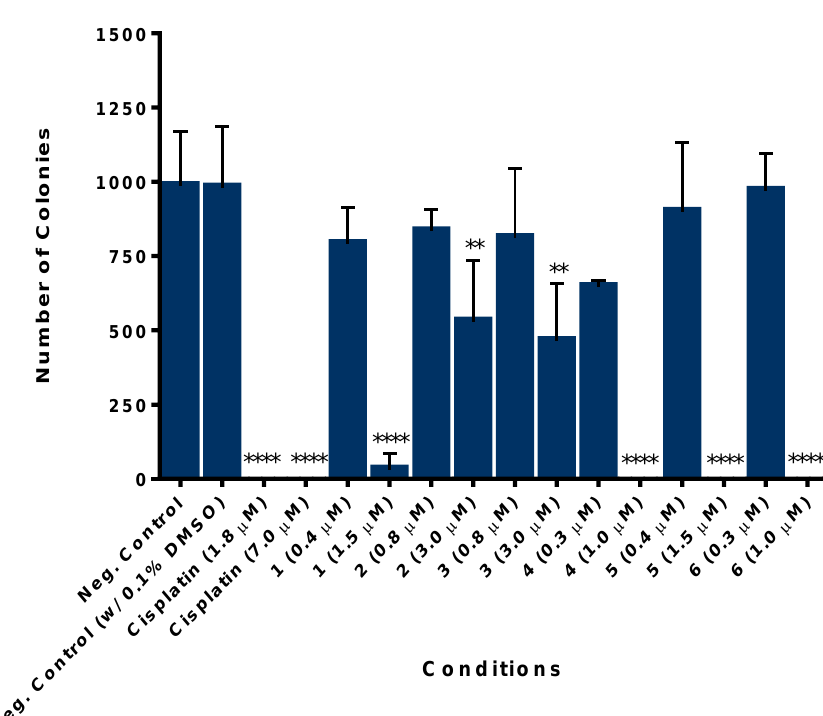
Figure 8. Iron compounds affect the colony formation ability of SW480 cell line. Analysis of the colony formation ability, after 48 h of incubation with ¼ IC 50 and IC 50 , in SW480 cell line. The values represent mean ± S.D. of at least three independent experiments. Statistical analysis was performed by one-way ANOVA with Dunnett’s multiple comparisons test. ** P ≤ 0.01; **** P ≤ 0.0001 compared with negative control.